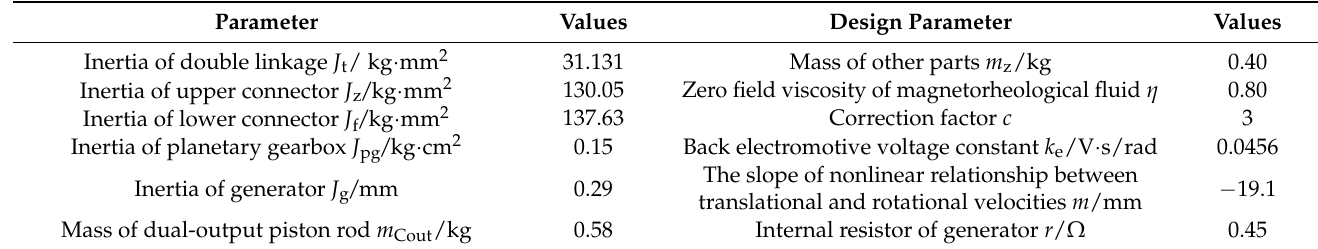
Table 2. Parameters of the prototype of the self-powered MR